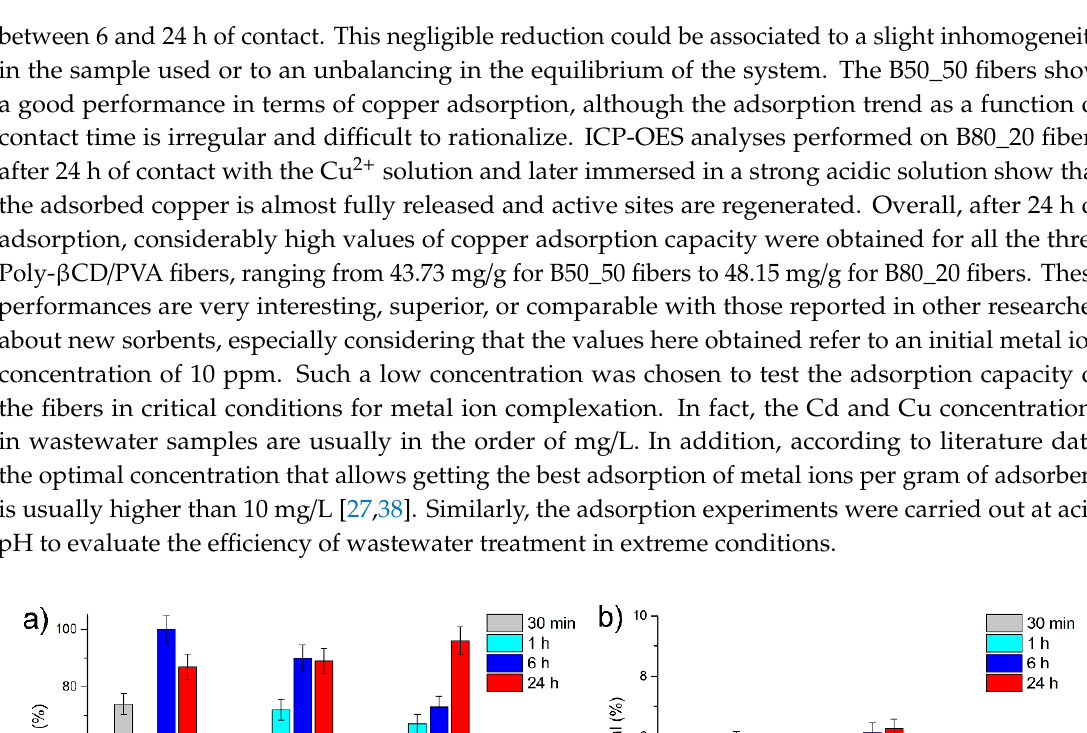
Figure 8. Copper ( a ) and cadmium ( b ) removal from aqueous solutions containing 10 mg/L of Cu and Cd respectively after different contact times (30 min, 1 h, 6 h, and 24